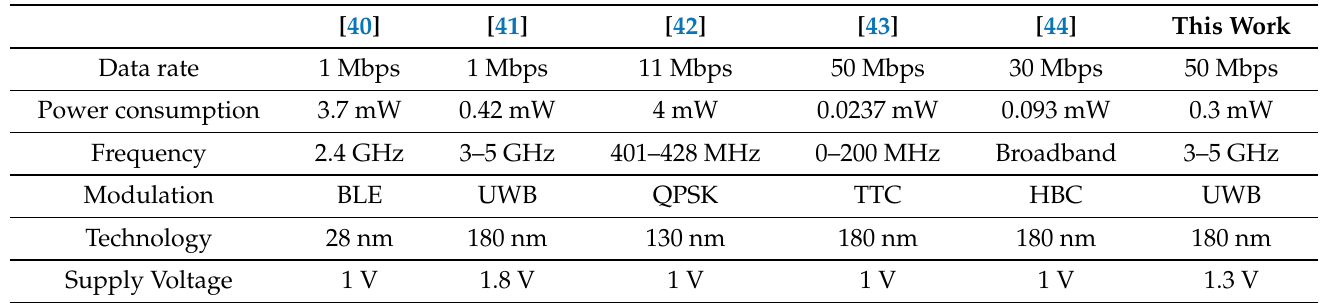
Table 2. Comparison with recently published IC-transmitter. (HBC—Human body communication, TTC—Transmission time control).